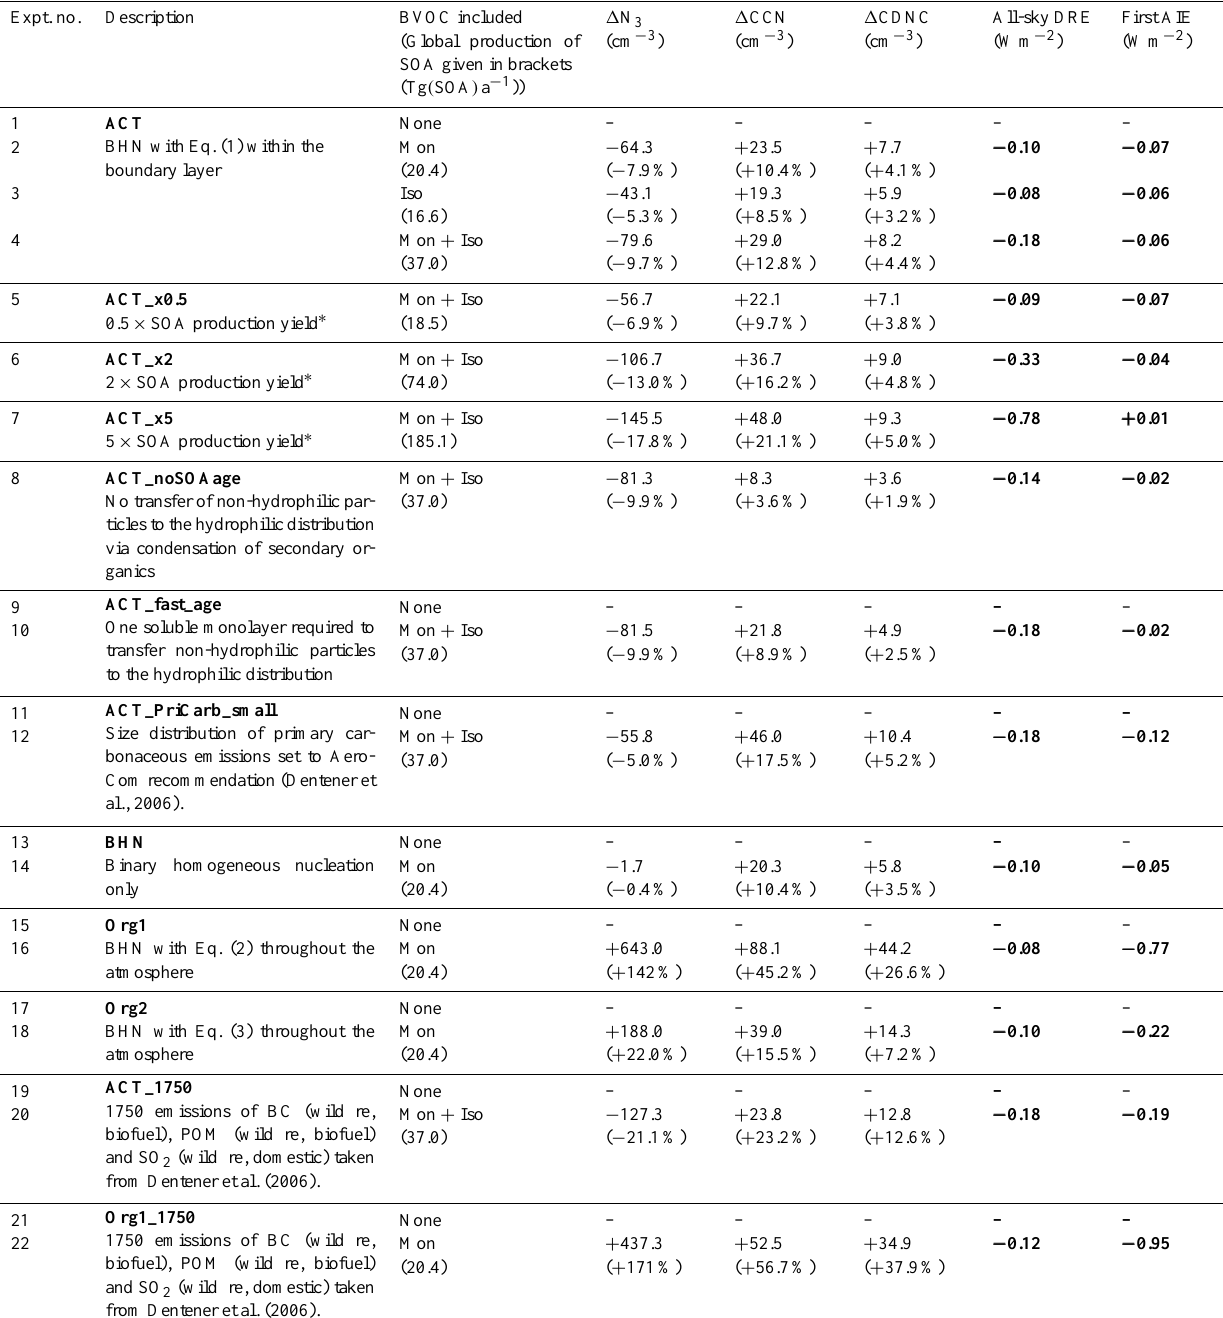
Table 2. Summary of model simulations and global annual mean changes to N 3 (number concentration of particles >3nm diameter) at the surface, surface level CCN (0.2% supersaturation) concentration, and CDNC at cloud height (approximately 900hPa), with subsequent all-sky DRE and first AIE (highlighted in bold text), relative to an equivalent control simulation including no BVOC emission (Mon = monoterpenes, Iso =